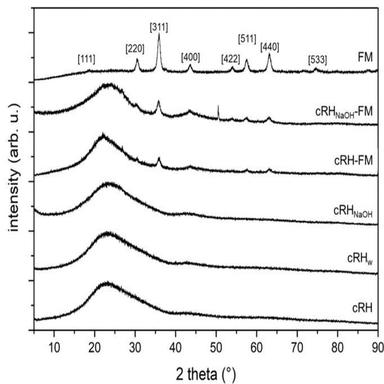
XRD patterns of the materials.